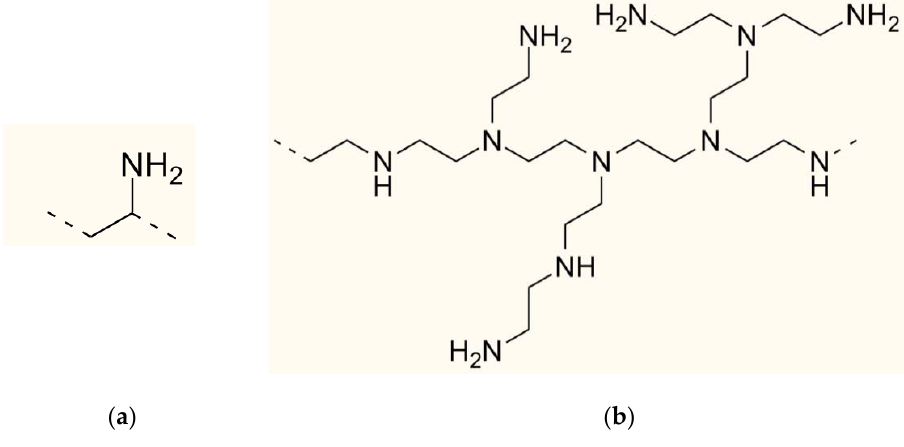
Figure 1. Elementary units of PAH ( a ) and PEI ( b ).